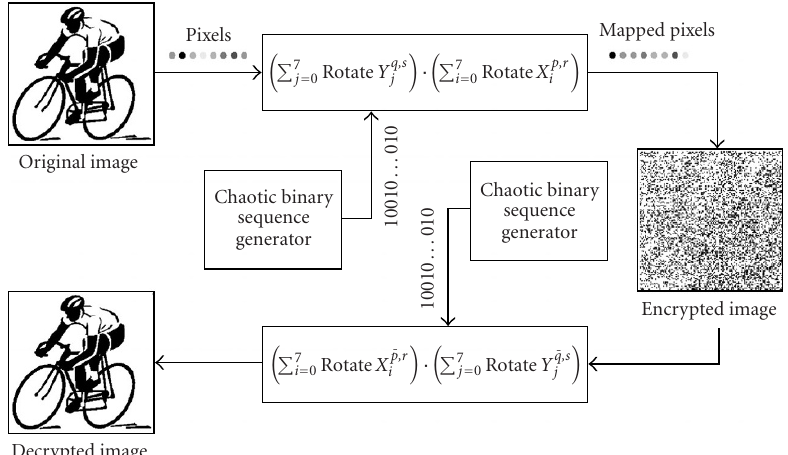
Figure 1: The block diagram of the proposed signal security system applied to a still image